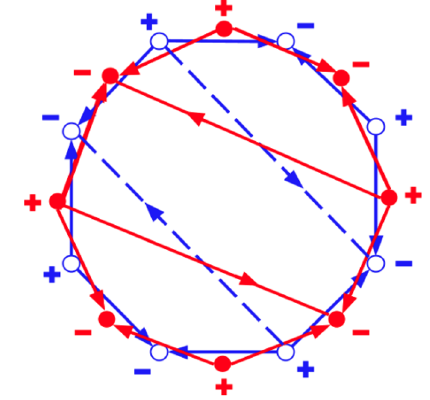
Figure 4 . An example of a red quadrangulation compatible with a blue